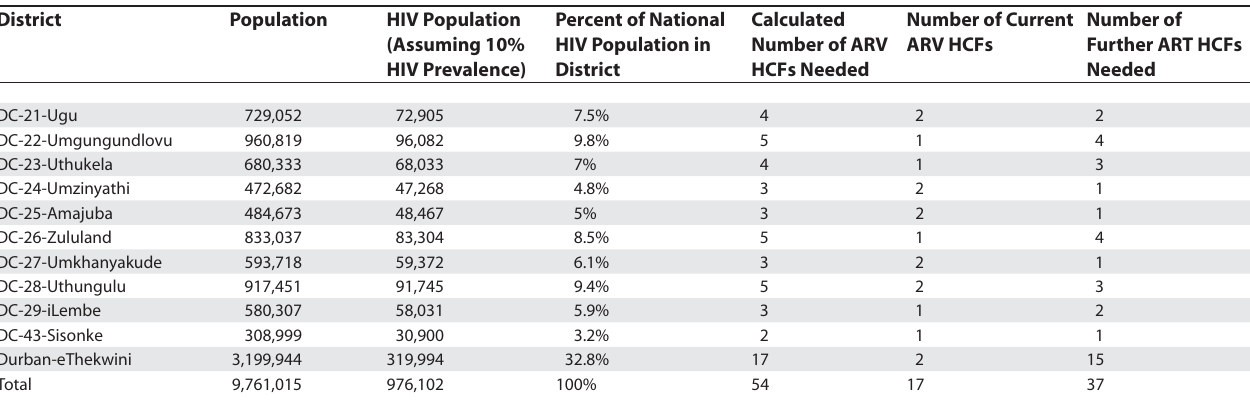
(Assuming 10% HIV